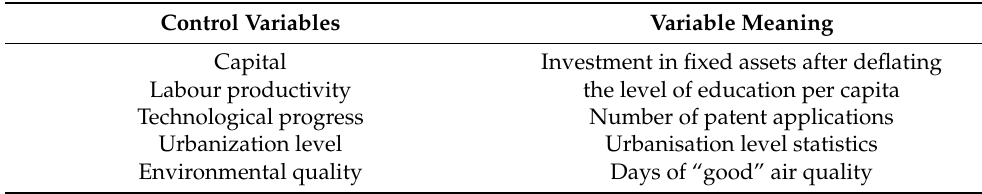
Table 1. Definitions of control variables.